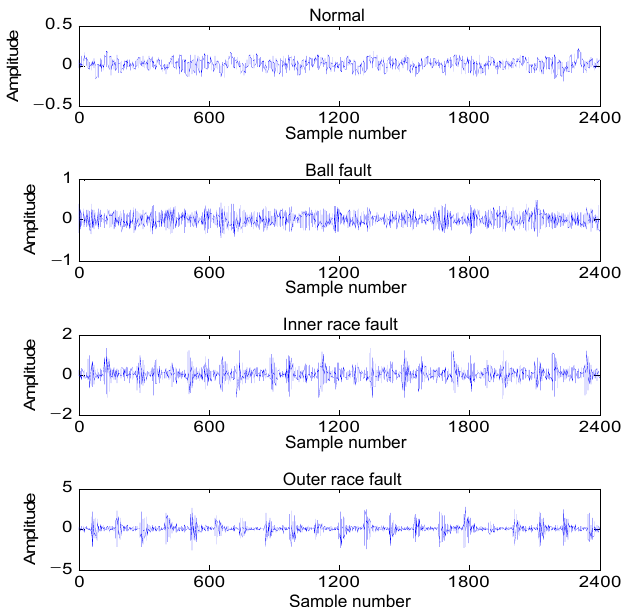
Figure 5. Vibration signals collected under different rolling bearing conditions for a load of 0 hp. Table 3. Working conditions of the collected rolling bearing data.